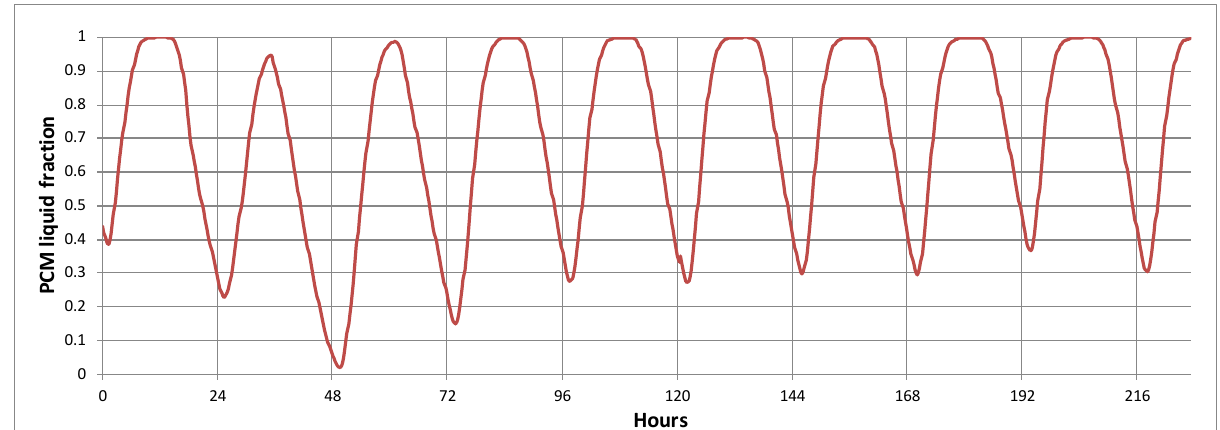
Figure 16. Evolution of the PCM liquid